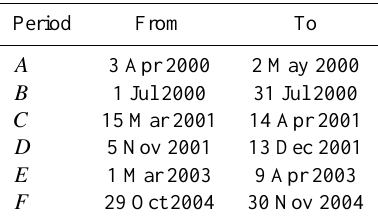
Table 1. Time intervals of 1-min Sym-H index analyzed in the present study. Period From